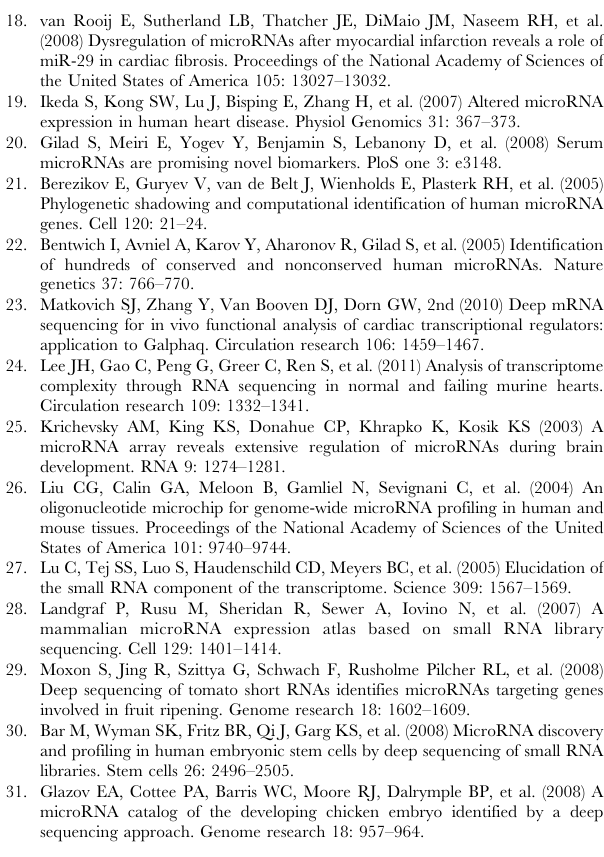
Table S1 Demographic/clinical characteristics and echocardio- graphic indices of the 16 patients included in the study. Table S2 Primers sequences used for real-time PCR Analysis (PDF) Table S3 Quantification (normalized sequencing reads) of microRNAs in Non-Failing (NF), Dilated Cardiomyopathy (DCM) and Hypertrophic Cardiomyopathy (HCM) human hearts. p values for DCM versus NF, HCM vs NF and DCM vs HCM are given. Colored columns depict q values (False Discover Rate - adjusted p values) for the different comparisons. MicroRNAs that have been previously involved in cardiac disease are marked in red. MicroRNAs that are differentially expressed between DCM and HCM (based on normal p values , 0.05) are depicted in